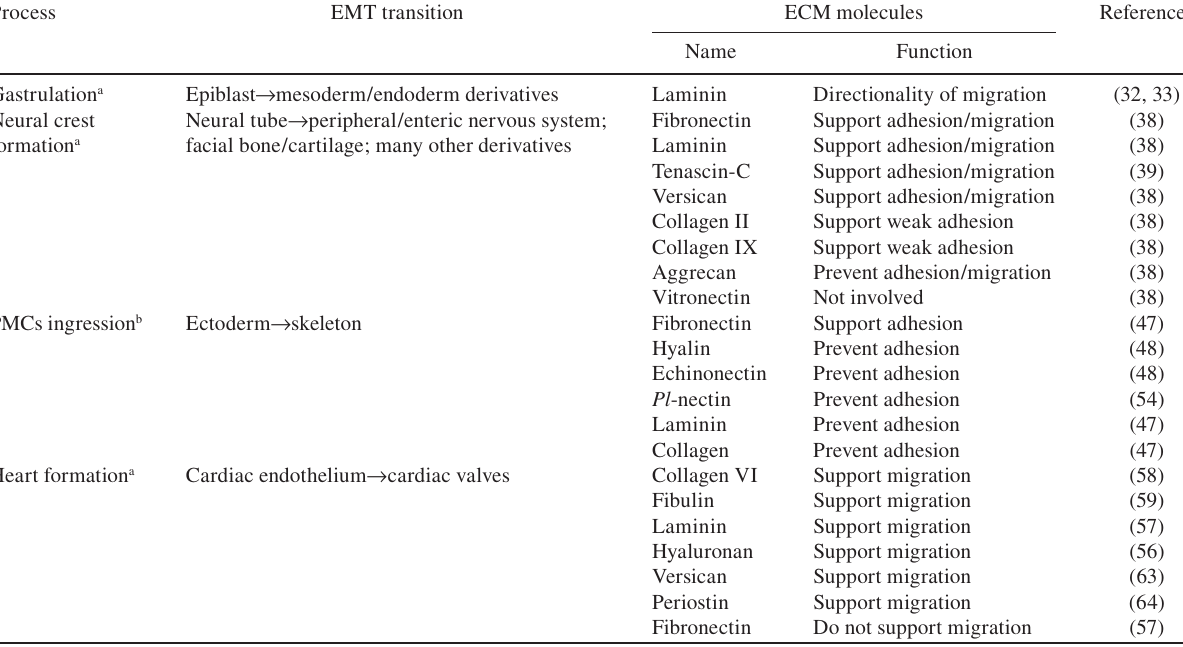
Table 1 ECM molecules involved in the embryonic EMT processes described in the text.